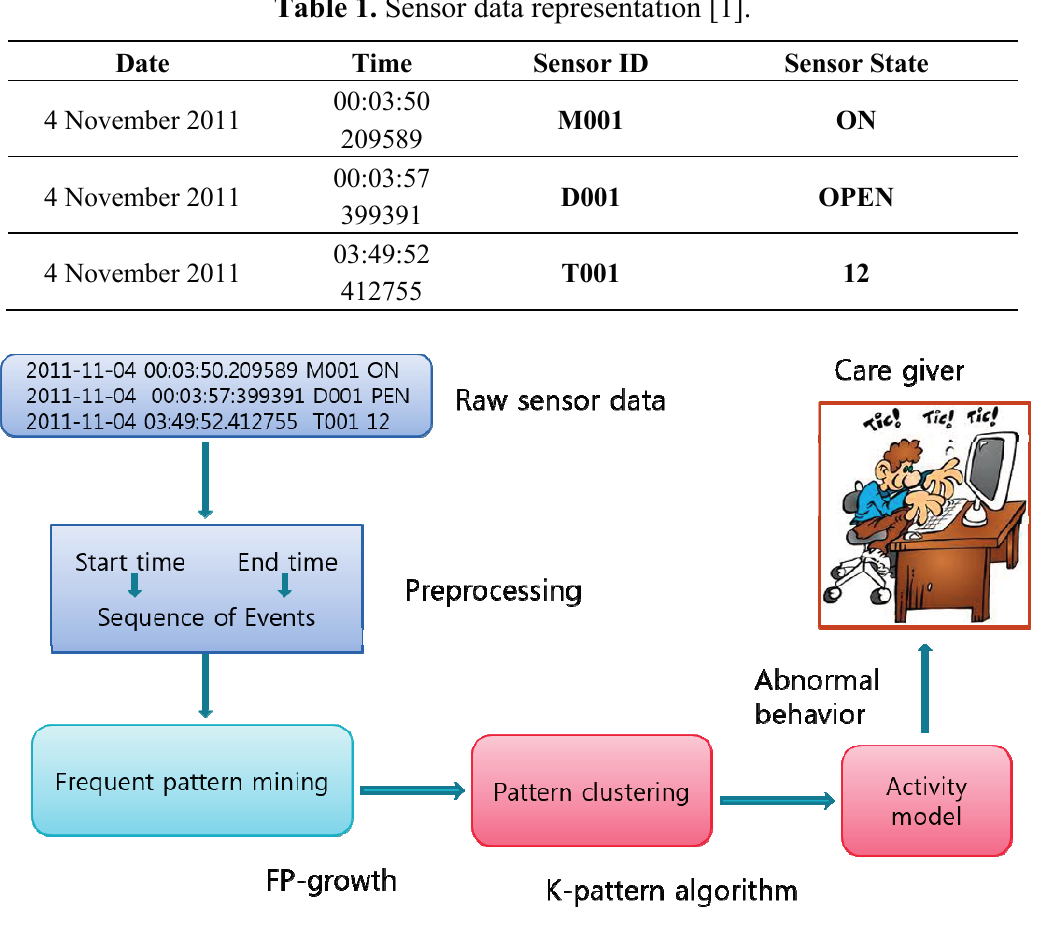
Figure 4. Architecture of tracking activity using K-pattern algorithm